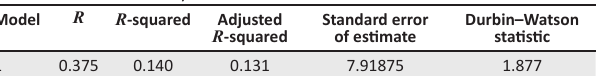
TABLE 4: Model summary.